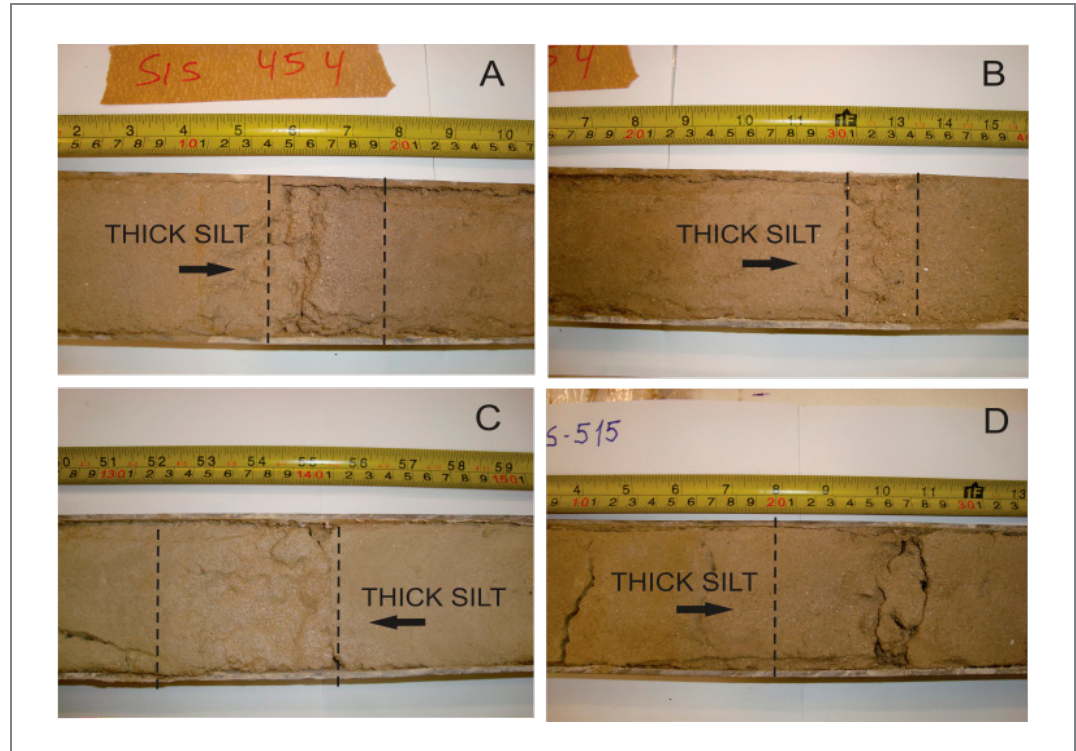
Figure 3 - SIS 454 thick silt intervals (A) 14 to 19 cm, (B) 30.5 to 34 cm, (C) 132 to 141cm, and SIS 515 (D) 20 to